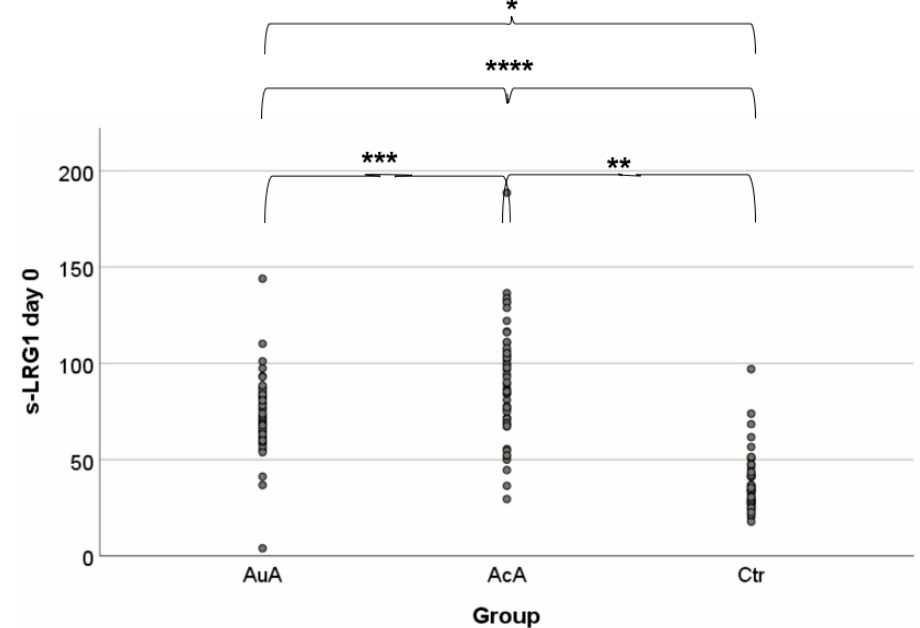
Figure 1. s-LRG1 of each patient group. s-LRG1 levels are increased in patients with AA ( n = 97) compared to the control group ( n = 56), **** p < 0.001. s-LRG1 could detect disease progress when analyzing AcA ( n = 52) and AuA ( n = 45), *** p = 0.001. A significant difference was recognized when the control group was compared to AcA and AuA separately; * p < 0.001 and ** p < 0.001,